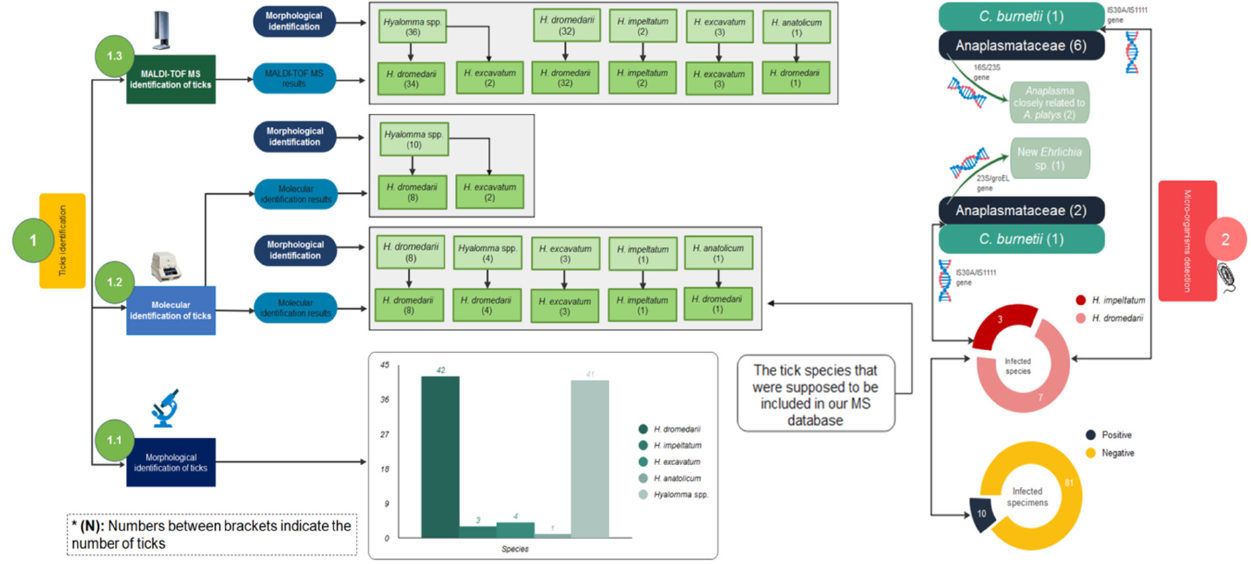
Figure 4. Study design showing two sections: tick identification and microorganism identification. The first section is summarized by a flowchart including morphological identification results (1.1), molecular identification results (1.2) and MALDI-TOF MS analysis results (1.3). The second section includes qPCR and sequencing results using different